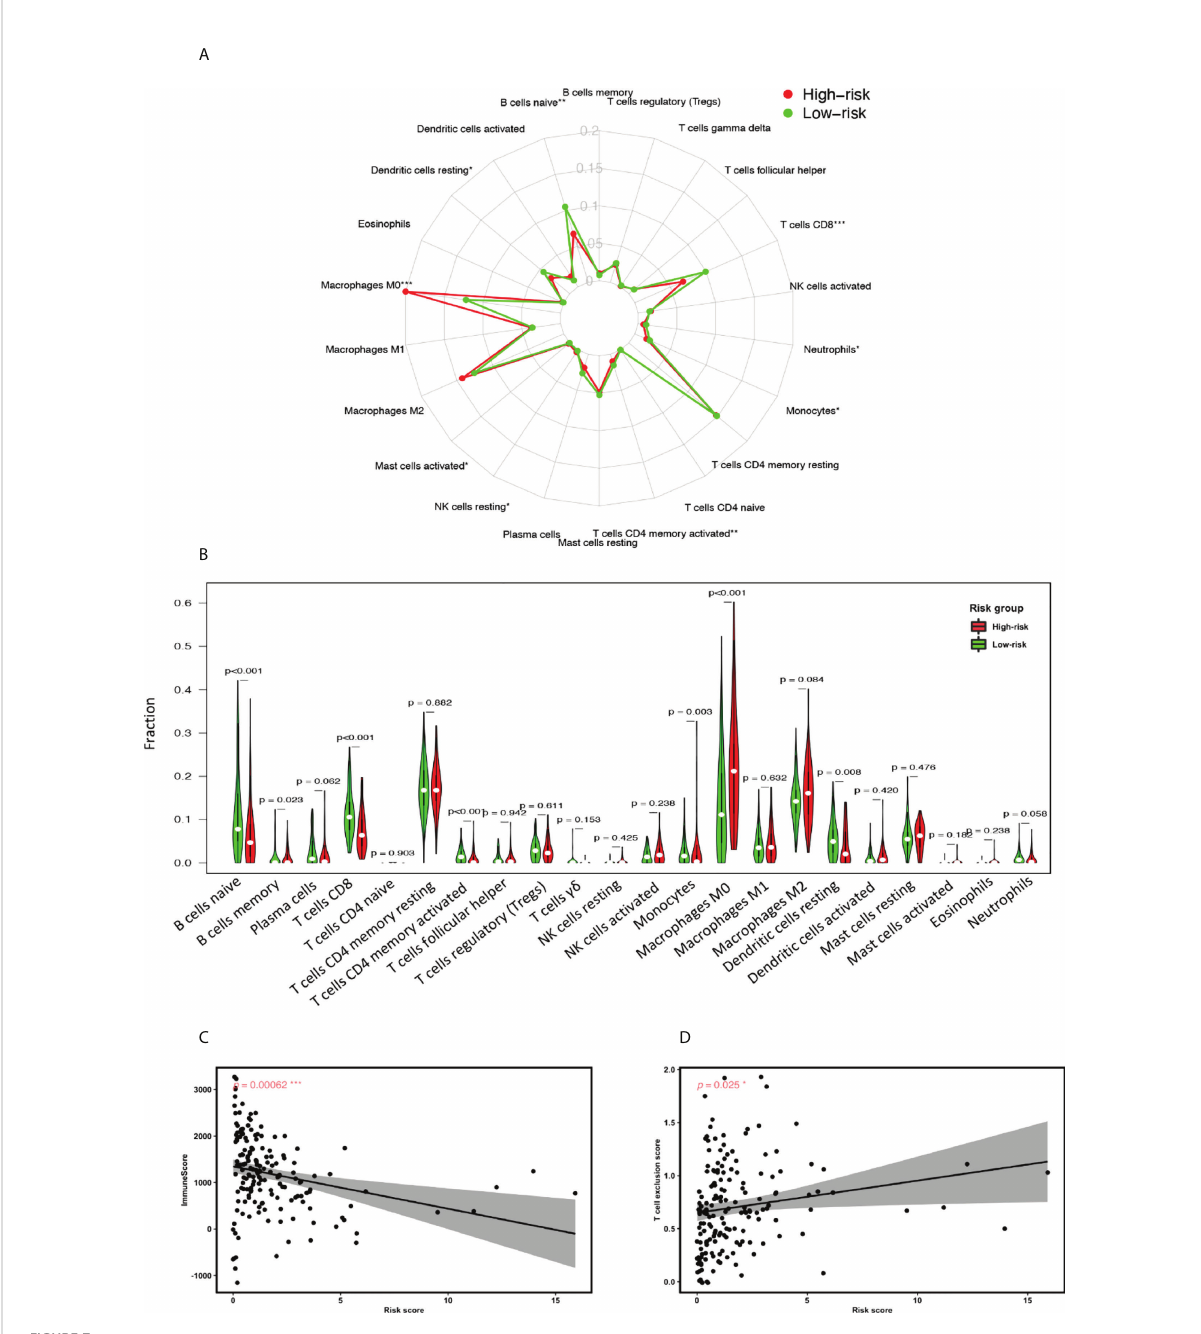
FIGURE 7 GILncSig associated tumor microenvironment (TME) assessment. (A) Radial plot highlighting the differences of the median proportion of 22 immune cell types in the TME of PDAC patients in the high-risk and low-risk groups. (B) Statistical comparison of the fraction of 22 immune cell types in the TME of patients in the high-risk and low-risk groups assigned based on GILncSig. Red represents the high-risk group and green represents the low-risk group. (C) Pearson correlation analysis between Immune Score and GILncSig risk score. (D) Pearson correlation analysis between T cell exclusion score and GILncSig risk score. *P< 0.05; **P< 0.01; ***P<